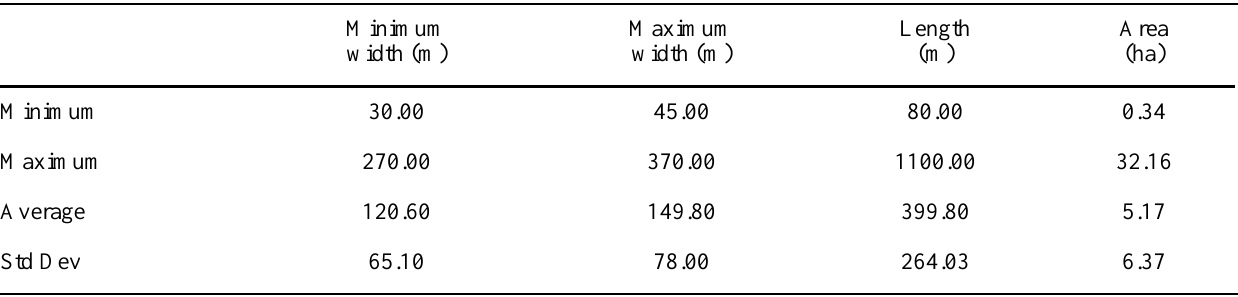
Table 3 . Summary statistics for tuuhiikan dimensions. Minimum, maximum, average, and standard deviation are reported for width (meters), length (meters), and area (hectors). Many tuuhiikaan tend to be wider at one or both ends, thus a minimum and maximum width was measured for each.